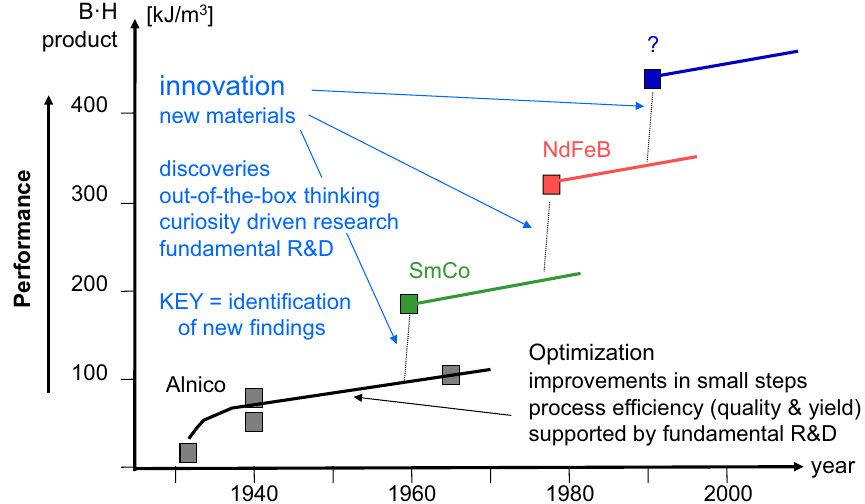
Fig. 1 Illustration of the evolution of materials performance related to optimization and innovation. Exemplary, the evolution of hard mag- netic materials is shown as they are indispensable in performance electrical transportation, wind energy and mechatronics in general. The so-called B·H product represents the magnetic energy stored in the materials and directly reflects the magnetic field flux that can be real- ized in a magnetic device. Significant performance improvements stem from new materials through innovation. Still, optimization is neces- sary to further improve the applicability of the new materials as well as the processing yield. Magnetic property data were taken from